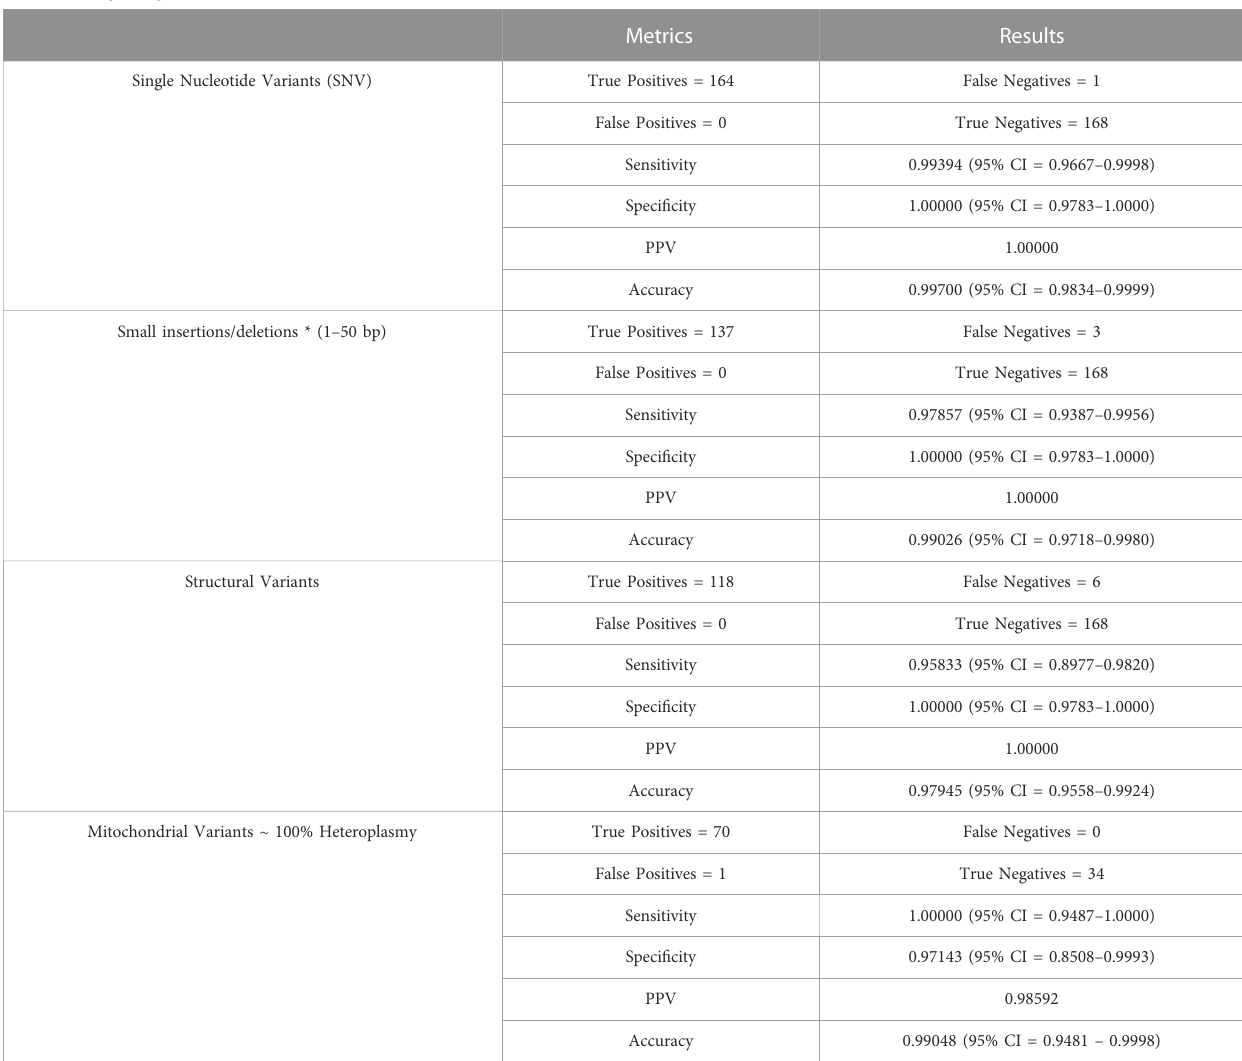
TABLE 1 Analytical performance